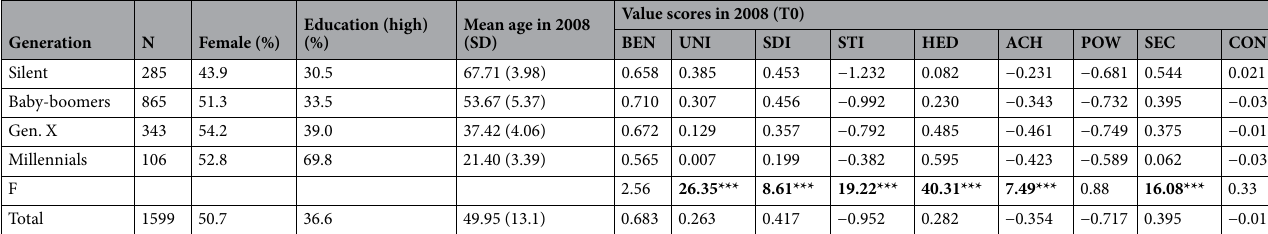
Table 7. Demographics, means of the nine human values-types in 2008 (T0), and difference test (ANOVA). Value-types are measured in 2008 (T0). Education is education in 2020 (T6) to appropriately reflect the level of education of the Millennials. BEN = benevolence, UNI = universalism, SDI = self-direction, STI = stimulation, HED = hedonism, ACH = achievement, POW = power, SEC = security, CON = conformity. Differences between generations are statistically significant for all valuesexcept benevolence, power, and conformity. Significant values are in bold. *p < 0.05. **p < 0.01. ***p <